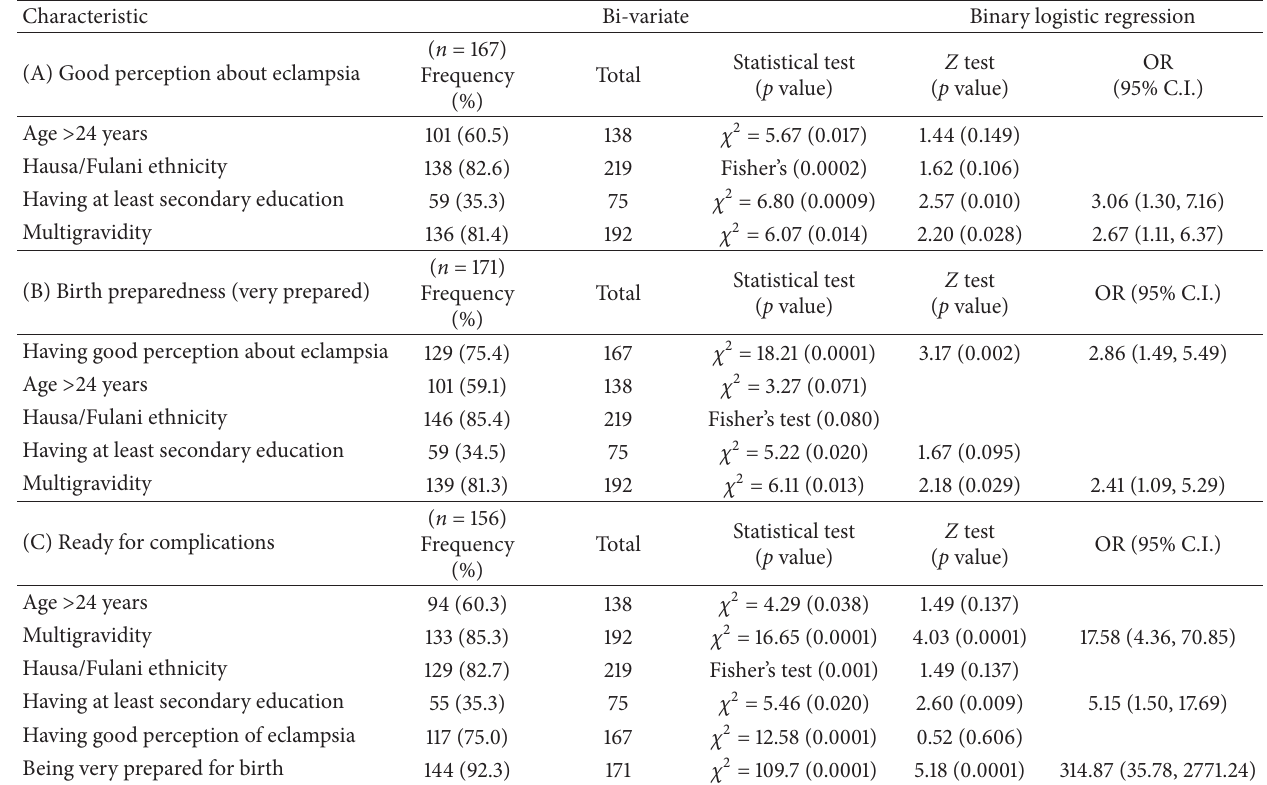
Table 5: Factors associated with the ANC clients’ perceptions about eclampsia, birth preparedness, and complications readiness.